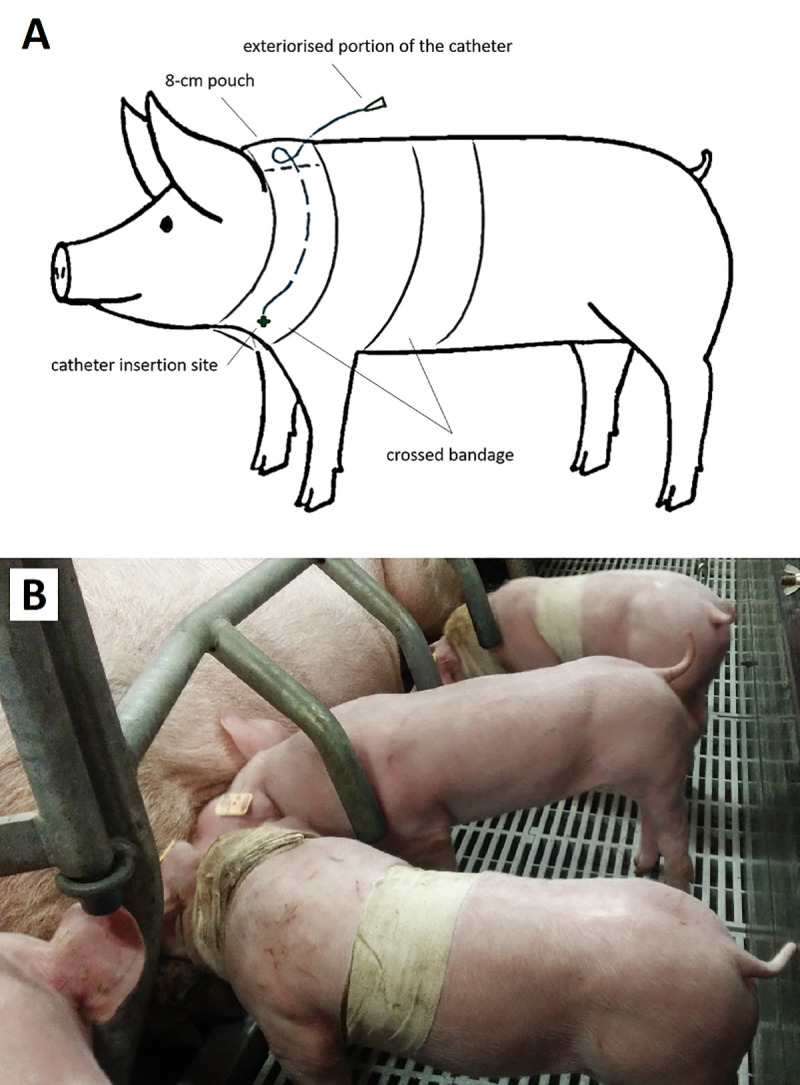
A. Schematic view of catheter positioning in 21-day-old piglets at the end of the catheterization procedure. B. Photograph that shows piglets equipped with catheter during the suckling period. The catheter was covered with a crossed bandage around piglet’s neck and abdomen to ensure overall protection of catheter insertion site. The catheter was routed between two layers of bandage and the exteriorised portion of catheter was placed in a 8×8-cm pouch on the dorsal surface of the neck. Piglets were group-housed for 7 days after the surgical procedure.